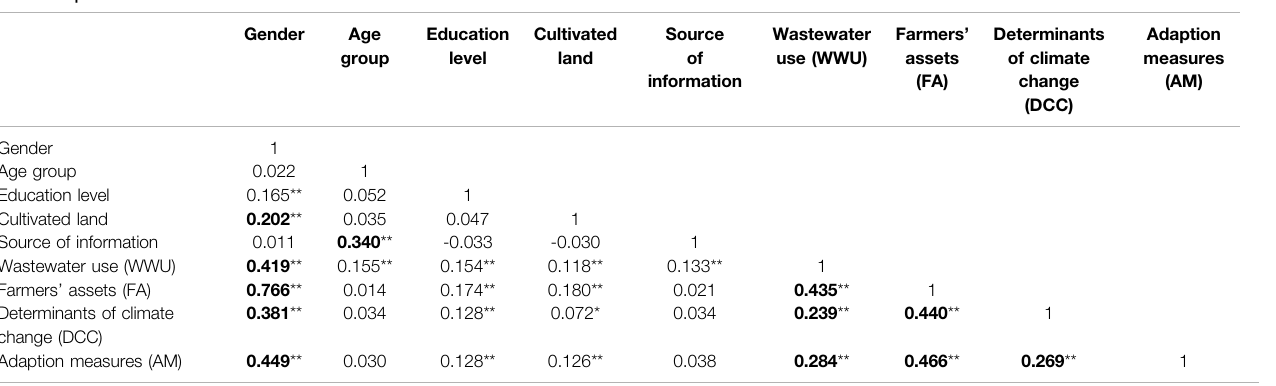
TABLE 4 | Correlation of selected